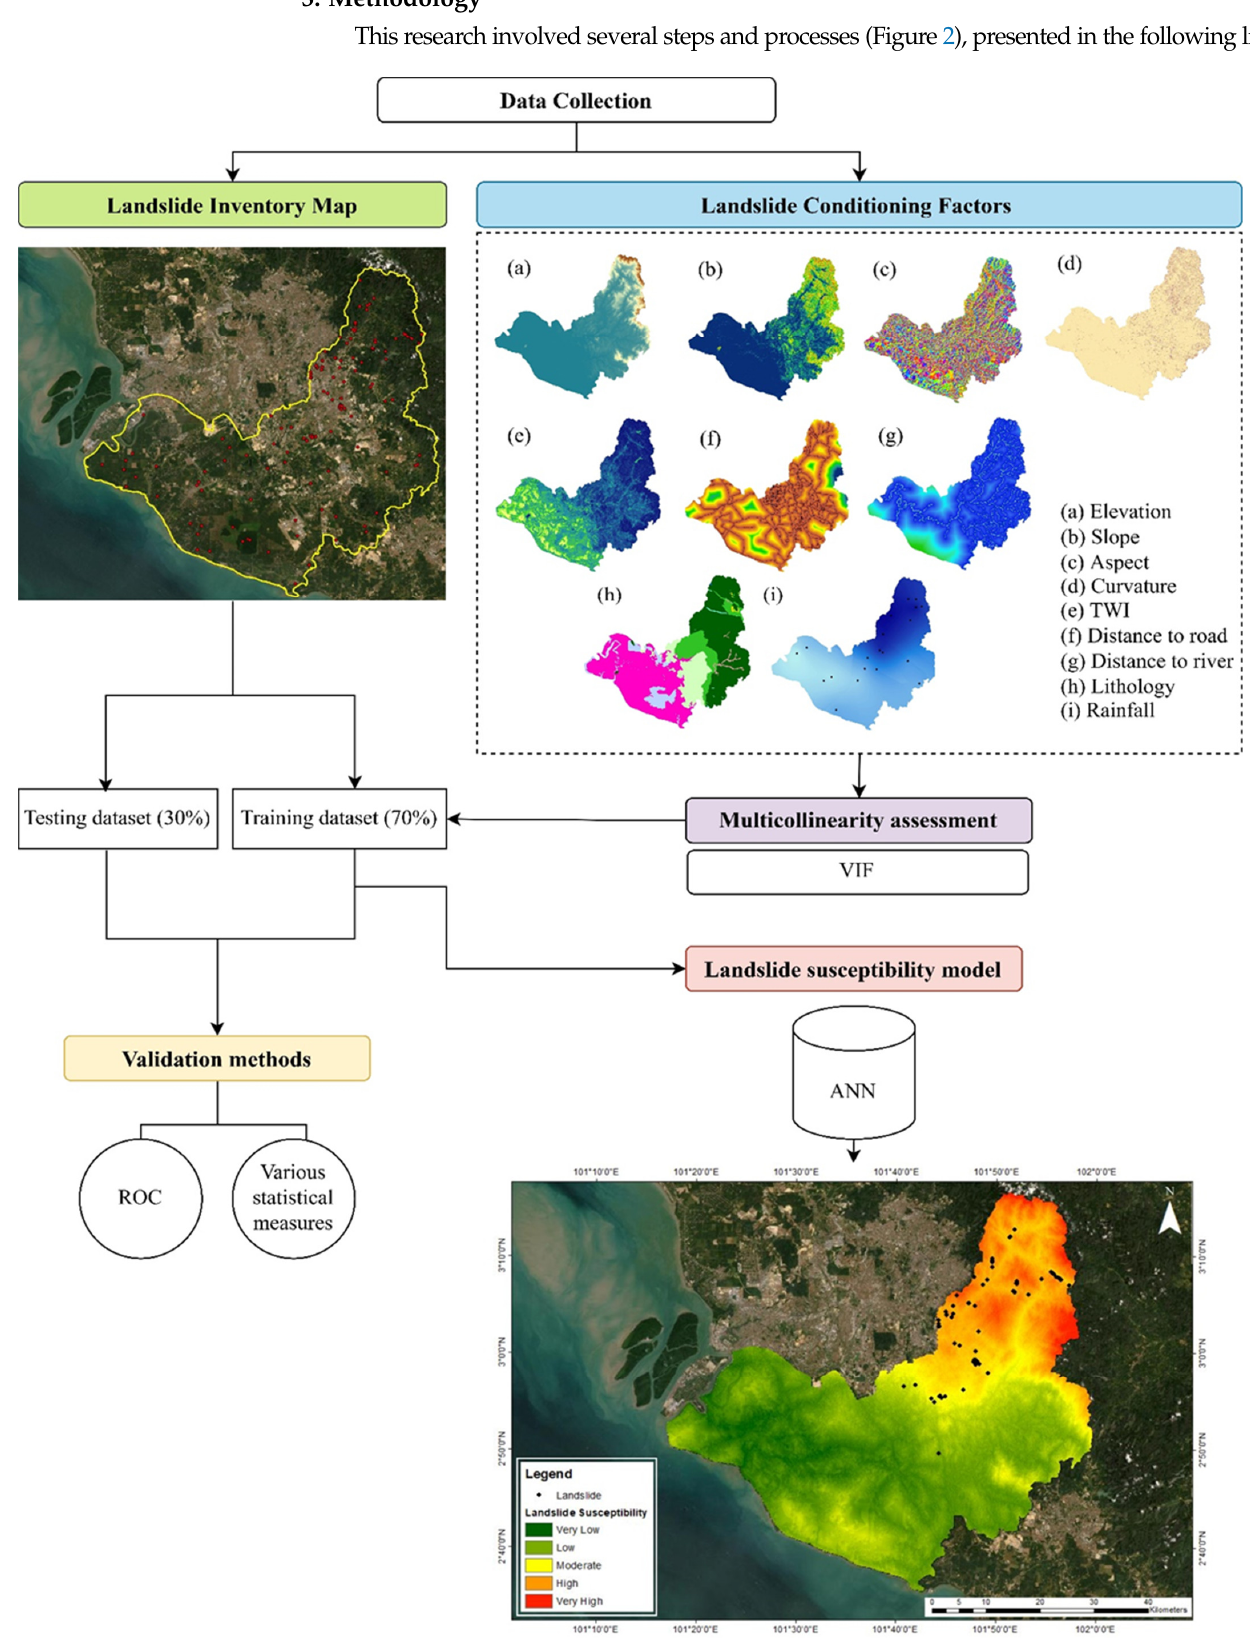
Figure 2. Flow chart of the methodology.